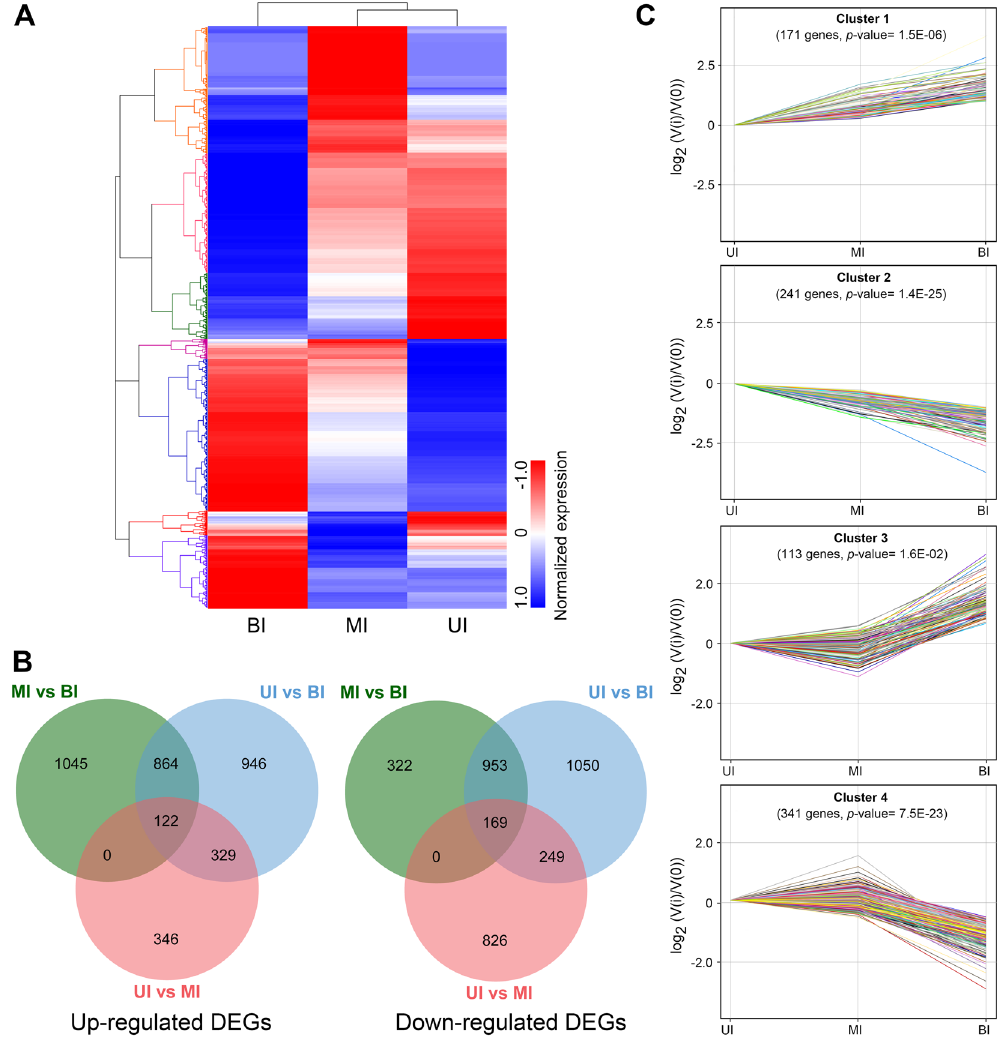
Figure 4. Transcript profiling of genes across three internode segments. ( A ) hierarchical clustering of all differentially expressed genes (DEGs) based on Z-score normalized FPKM values in three internode segments. Blue indicates lower expression, and red indicates higher expression. ( B ) Venn diagram showing the up-regulated or down-regulated DEGs among three internode segments. ( C ) expression patterns of four significantly clustered profiles. UI, upper internode, MI, middle internode, BI, basal